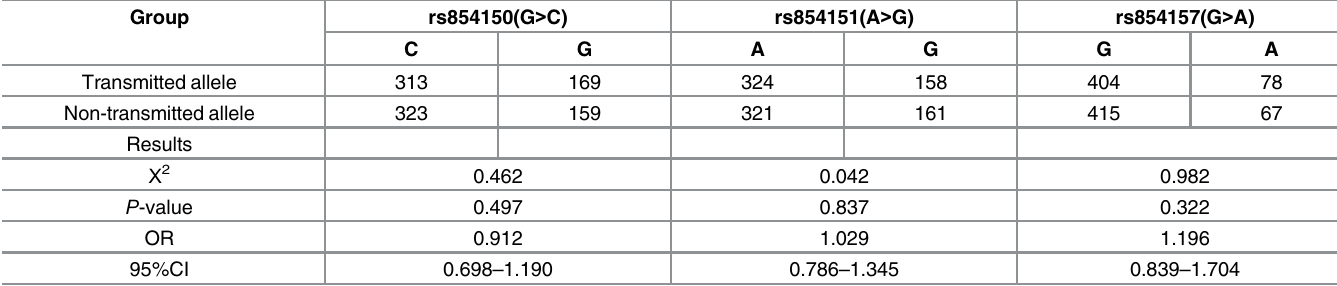
Table 3. HHRR results of three genetic loci in 241